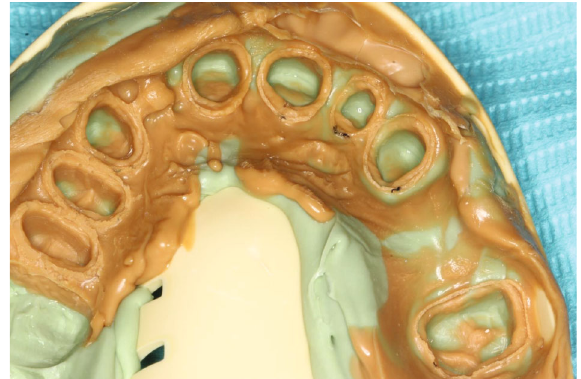
Figure 4: Final impression after tooth preparation using vinyl polysiloxane impression material.